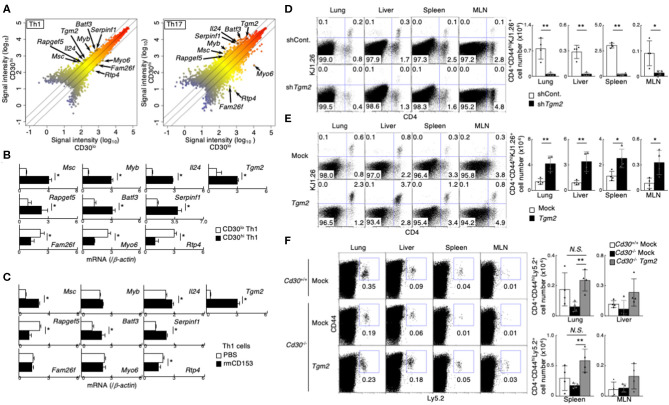
Importance of CD30 signaling-induced Transglutaminase 2 (TG2) expression on memory Th1 and Th17 cell generation. (A) Scatterplot showing the correlation of gene expression in cDNA microarray analysis between CD30hi vs. CD30lo cells in Th1 (left) and Th17 (right) cells. Signal intensities (log10) are shown. Differentially expressed genes were selected using the following criteria: (1) signal “present” call and (2) signal intensity >= 300 for higher expressed genes. (3) 2-1.5-fold change in gene expression. (B) mRNA expression of the indicated genes between CD30hi and CD30lo Th1 cells by qRT-PCR. Mean values with SDs are shown (*P < 0.01). (C) mRNA expression of the indicated genes after recombinant mouse CD153 stimulation. Naïve CD4 T cells were cultured under Th1 cell conditions for 24 h and the cells were treated with or without recombinant mouse CD153 (the protocol shown in Supplemental Figure 2C). Mean values with SDs are shown (*P < 0.01). (D,E) Effects of TG2 knockdown (D) and overexpression (E) on the generation of memory Th cells. DO11.10 Tg Th1 cells (the protocol shown in Supplemental Figure 2E). TG2 knockdown (D) and overexpressed (E) cells transferred into the host mice were detected based on their CD4 and KJ1.26 expression (left panels), and the absolute cell numbers of CD4+CD44hiKJ1.26+ transferred cells are shown (right panels). Mean values with SDs (n = 4) are shown (**P < 0.01, *P < 0.05). Data are representative of at least two independent experiments. (F)
Tgm2 or Mock retrovirus-transduced Ly5.2 Cd30 sufficient or deficient Th1 cells (5 × 106) were transferred into Ly5.1 mice, and these mice were analyzed 1 week later as shown in Supplemental Figure 2E. A representative Ly5.2/CD44 profile of the transferred CD4 T cells in the indicated tissues (left panels) and the absolute cell numbers of CD4+CD44hiLy5.2+ transferred cells (right panels) are shown. Mean values with SDs (n = 4) are shown (**P < 0.01, *P < 0.05). Data are representative of at least two independent experiments.